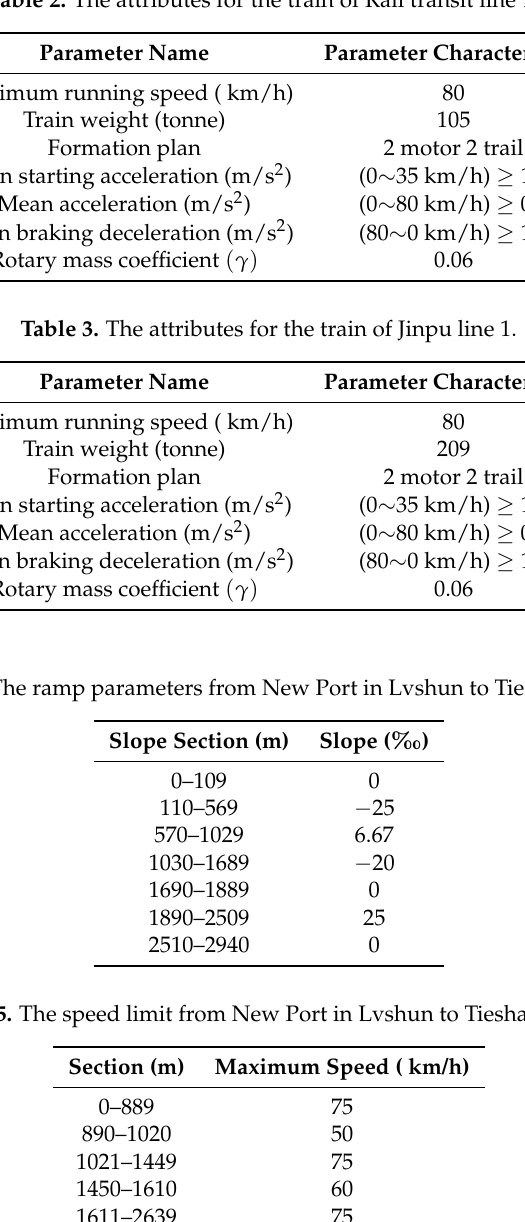
Table 2. The attributes for the train of Rail transit line 12.